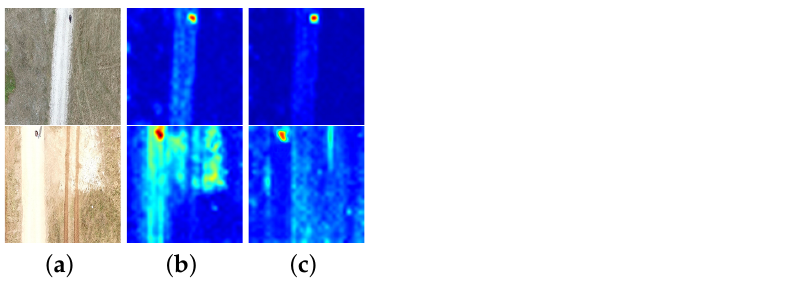
Figure 6. In ( a ), image samples depicting abnormal conditions; in ( b , c ), the heat maps produced by the localizer without and with residual blocks,